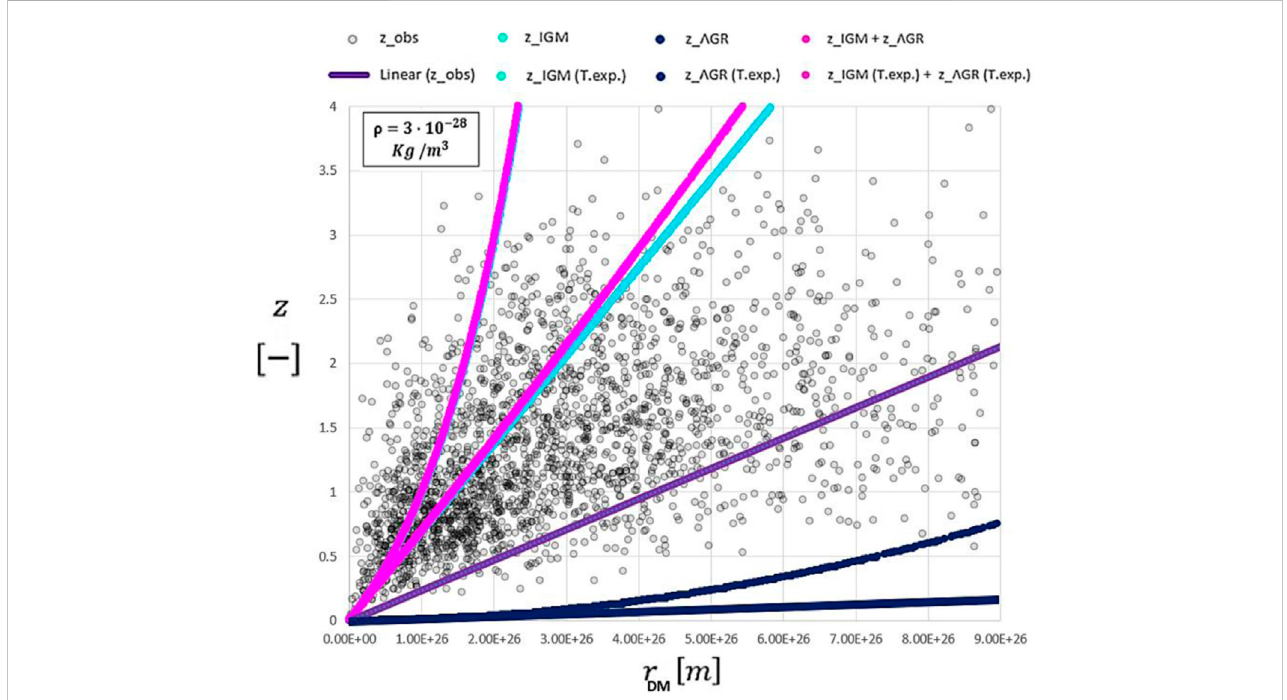
FIGURE 12 Comparison between quasar redshifts (gray dots) and its linear trend (violet line) with nominal redshifts determined by pure formulations (fuchsia, sky- blue, and blue exponential curves) and by Taylor expansion (fuchsia, sky-blue, and blue lines) reported as “ T.exp. ” Lines and curves of this plot are affected by errors due to the calibration of the QSO